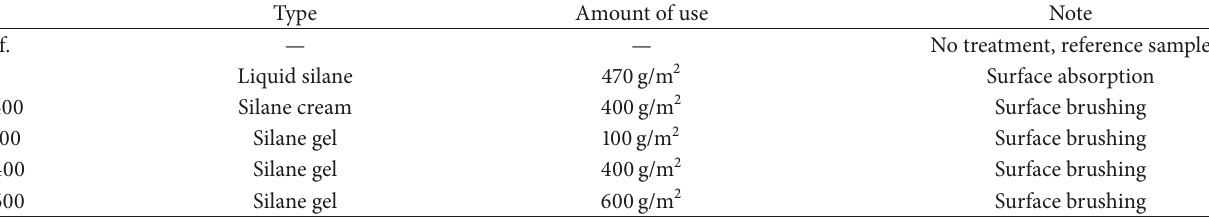
Table 2: Three types of water repellent agents used in this project and their uses.